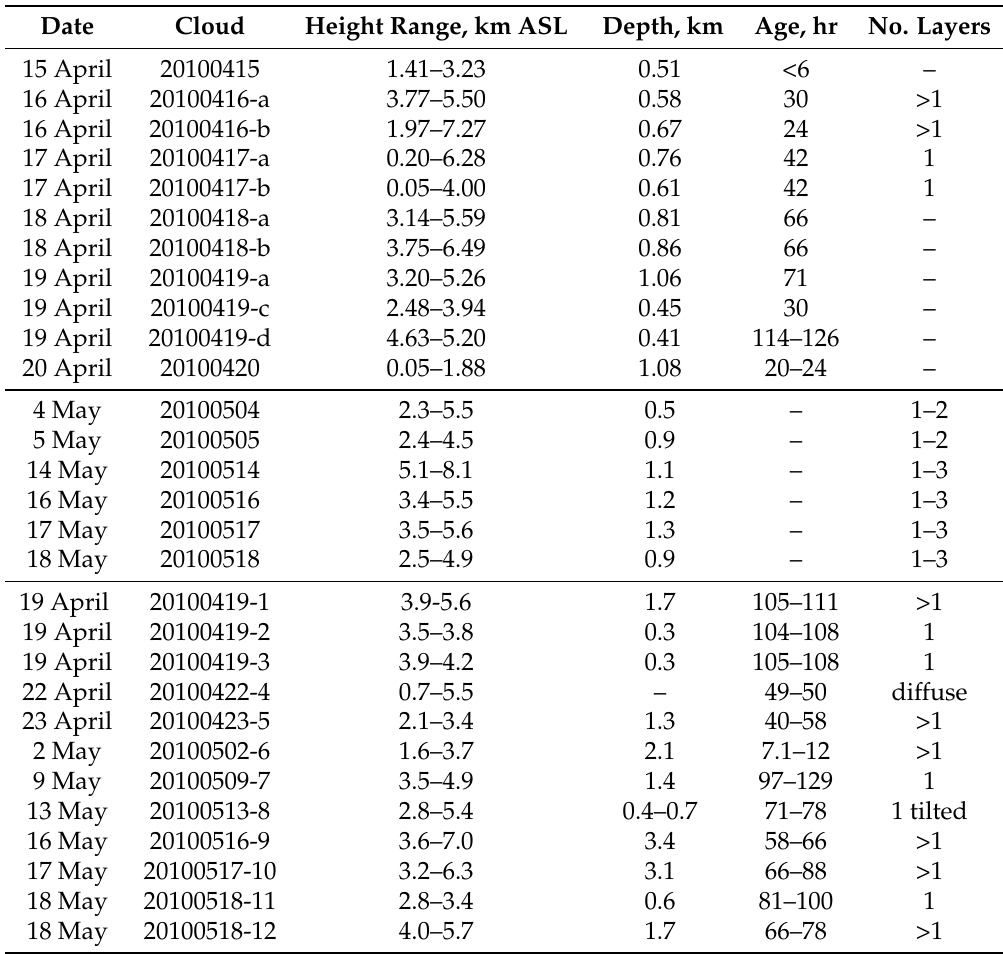
Table 2. Measured distal Eyjafjallajökull cloud depths from CALIOP lidar. Data from Winker et al. [49] (top section), Marenco et al. [50] (middle) and Schumann et al. [51] (bottom). Note that the number of layers varies with spatial position.